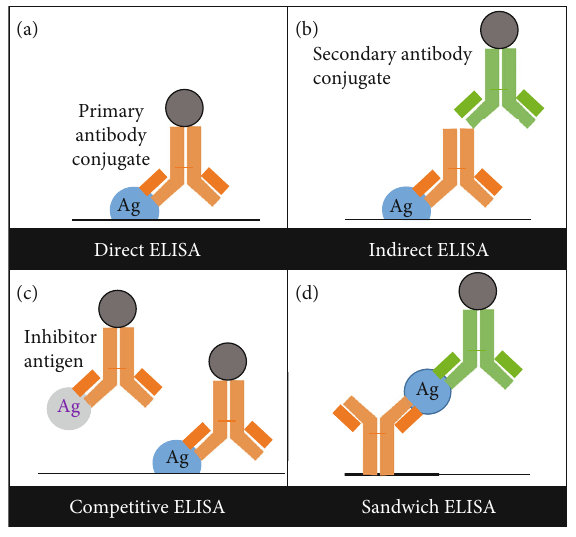
Figure 2: Types of ELISA. (a) Direct: an antigen is immobilized on the surface of a multiwell plate. A labeled primary antibody binds to the target antigen and is detected using an enzymatic substrate. (b) Indirect: an indirect ELISA consists of an unconjugated antibody binding to the target antigen, followed by a conjugated antibody. (c) Competitive: this assay is also known as an inhibition assay. The target antigen is precoated on a multiwell plate. An enzyme-labeled antibody is preincubated with the sample and may form antibody-antigen complexes with the inhibitor antigen before being added to the multiwell plate. The free antibody binds to the target antigen immobilized on the surface of a multiwell plate. A lower signal corresponds to a higher amount of antigen. (d) Sandwich: the sandwich “ capture ” assay is the most complex but provides sensitive and highly speci fi c detection using two antibodies that preferably bind to two di ff erent epitopes. The antigen binds to the capture antibody and is detected using a second “ detection ” antibody. A labeled secondary antibody is then used to produce a measurable